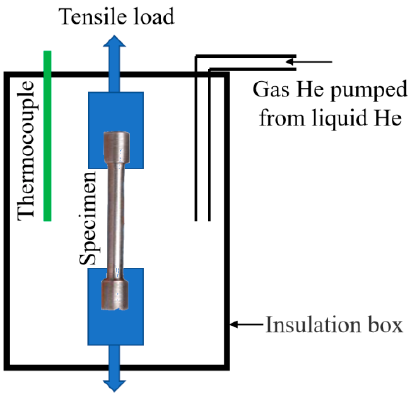
Figure 1. Schematic diagram of cryogenic tensile test process. Heat treated samples were mechanically polished and etched with 4% nital using standard metallographic procedures for TESCAN MIRA3 field emission scanning electron microscopy (SEM, TESCAN, Brno, Czech Republic). To obtain information on distribution and morphology of retained austenite, electron backscatter diffraction (EBSD, Oxford In- struments, Oxford, UK) analysis was carried out after mechanical and electrolytic polishing using TESCAN MIRA3 field emission scanning electron microscope (FE-SEM, TESCAN, Brno, Czech Republic) at an acceleration voltage of 20 kV, with a step size of 60 nm. EBSD data was post-processed by HKL CHANNEL 5 flamenco software (Oxford Instruments, Oxford, UK) to acquire necessary information. The amount of retained austenite was also evaluated using magnetic measurements [14]. For these measurements, samples were cut with approximately 150 mg. The M( H ) curves were obtained at 300 K using a PPMS (Phys- ical Property Measurement System, Quantum Design, San Diego, USA). The hysteresis loops were carried out using the following sweep rates: 0.4 kOe/min for | H | < 0.5 kOe, 1.8 kOe/min for 0.5 < | H | < 5 kOe and 10 kOe/min for 6 < | H | < 15